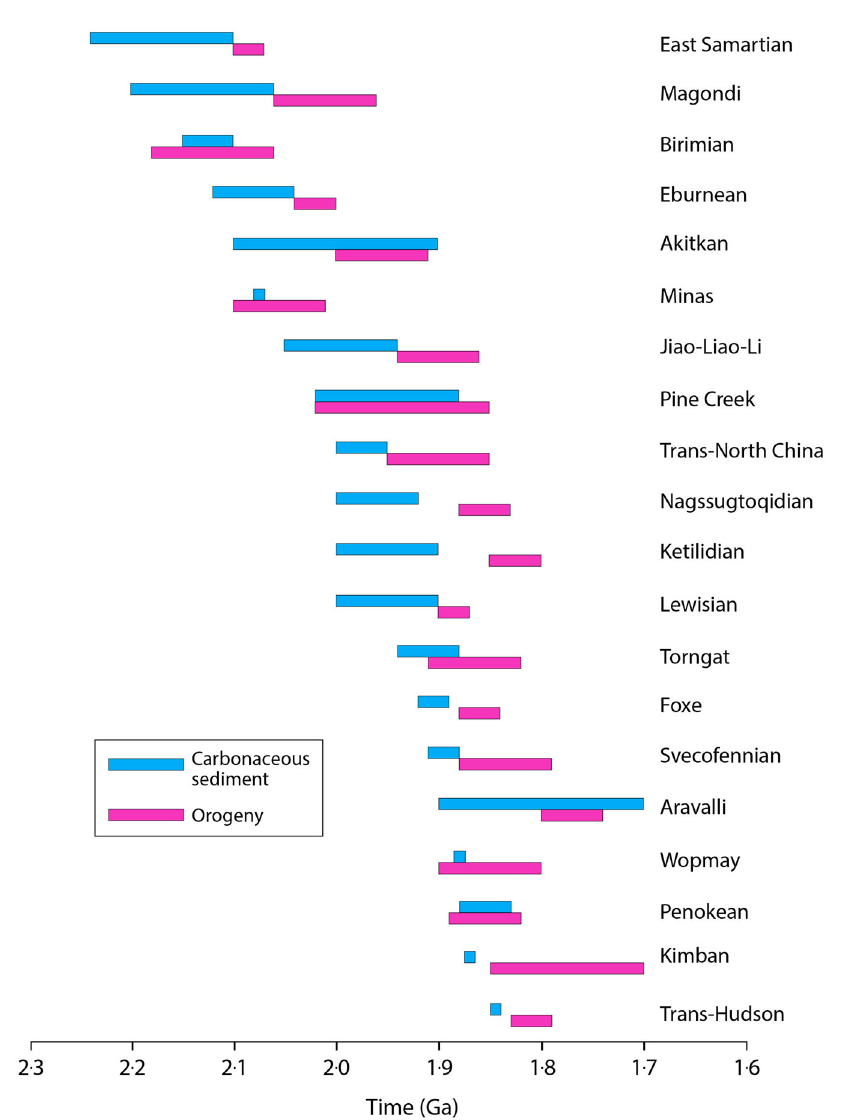
Fig. 3 Chronology of carbonaceous sediments and deformation in 20 Palaeoproterozoic orogens. Details in Table 1. The maximum interval between carbonaceous rocks (blue colour) and orogenic deformation (purple colour) is consistently <200 Myr, comparable to Phanerozoic